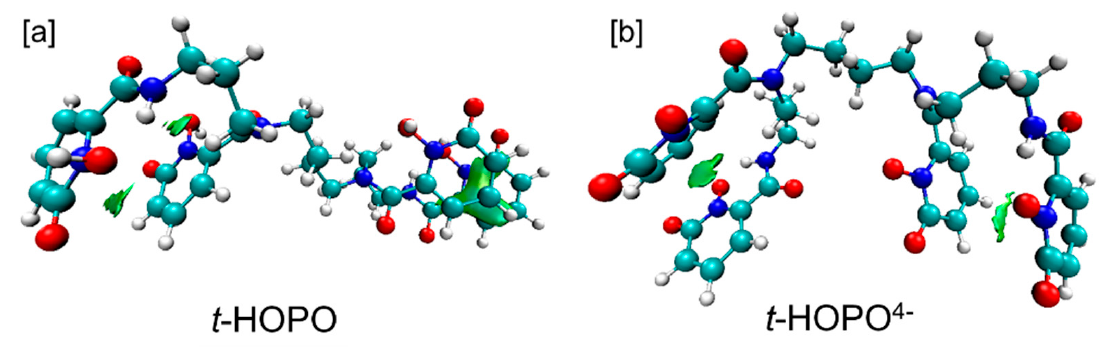
Figure 4. IGM analysis of intra-molecular non-covalent interactions between each pair of the four m -HOPO rings: ( a ) t -HOPO; ( b ) t -HOPO 4 − . The isovalues of the IGM descriptor δ g were 0.01. Color scheme: N atoms in blue, O atoms in red, C atoms in cyan and H atoms in white.